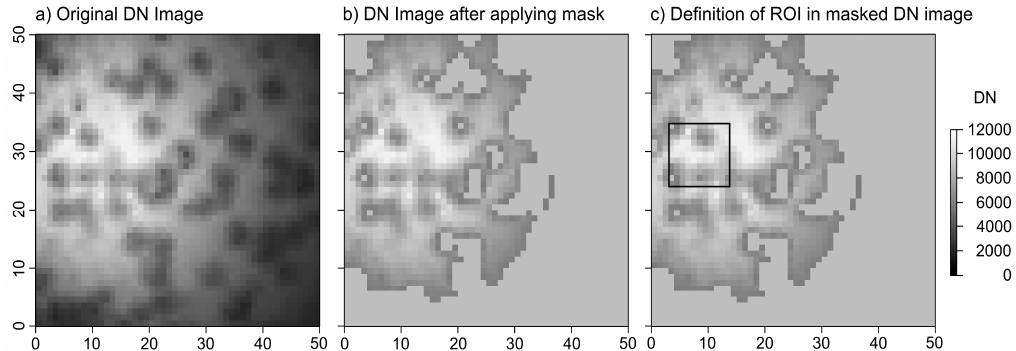
Figure 4. Image processing steps to extract optimal mean spectra for multivariate calibrations: ( a ) example of 2D image (at 710 nm) recorded near the bottom of the Auensee site where suspended particles and bubbles appeared during image acquisition; ( b ) masking of poorly illuminated image areas and interfering elements; ( c ) definition of a region of interest (ROI) around the ‘brightest’ pixel (at 710 nm).